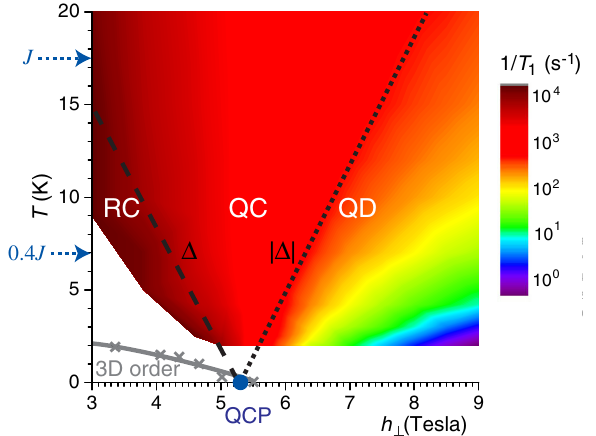
FIG. 8. The scaling plots of T þ 0 . 75 =T 1 as a function of Δ =T in (a) the RC regime and (b) the QD regime. For clarity, we normalized the overall magnitude of T þ 0 . 75 =T 1 as unity for the QC regime. The dashed-dotted line in (a) is a guide for the eyes, while the solid line in (b) represents 1 =T 1 ∝ e − j Δ j =T .